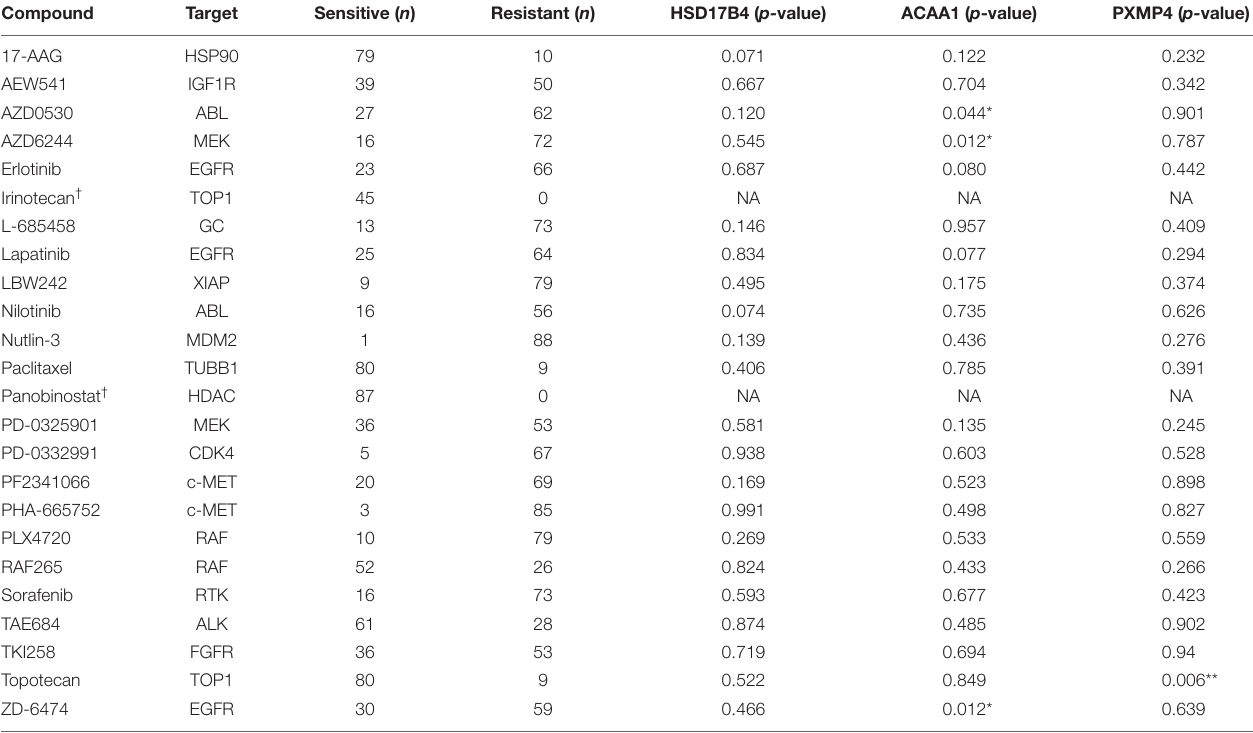
TABLE 3 | Expressional differences of HSD17B4, ACAA1, and PXMP4 between NSCLC cell lines with different anti-cancer drug sensitivity.